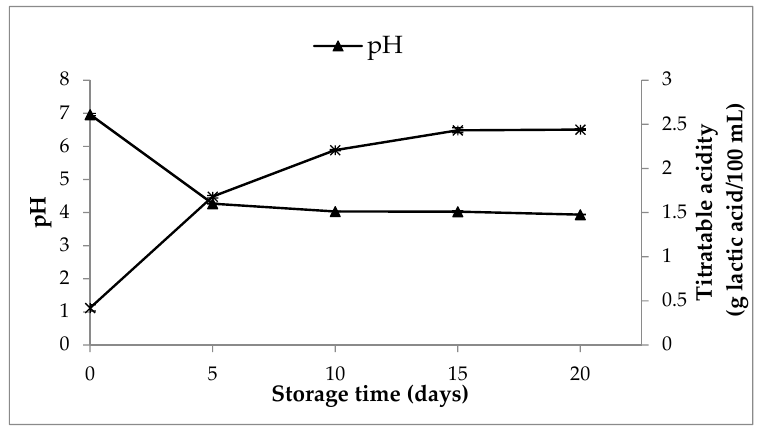
Figure 5. Variations in pH and titratable acidity of SOFB during storage at 4 °C for 20 days. Refrigerated storage did not significantly ( p > 0.05) affect WHC of SOFB (Table 5), results that indicate that despite the increased acidification over the storage period there in fermented dairy beverages